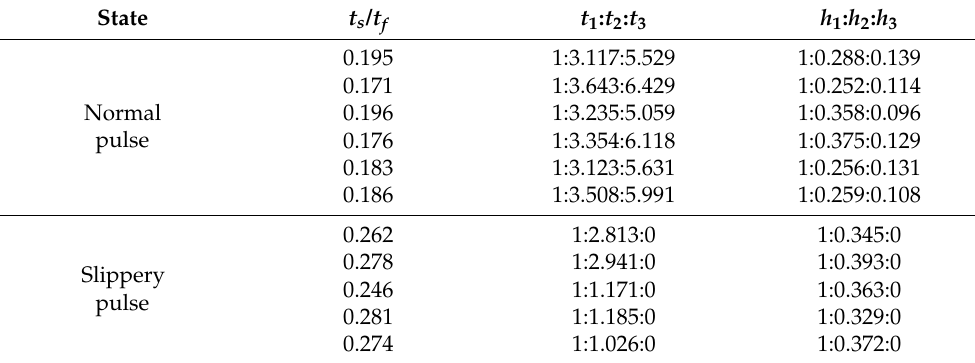
Table 1. The spatial-temporal